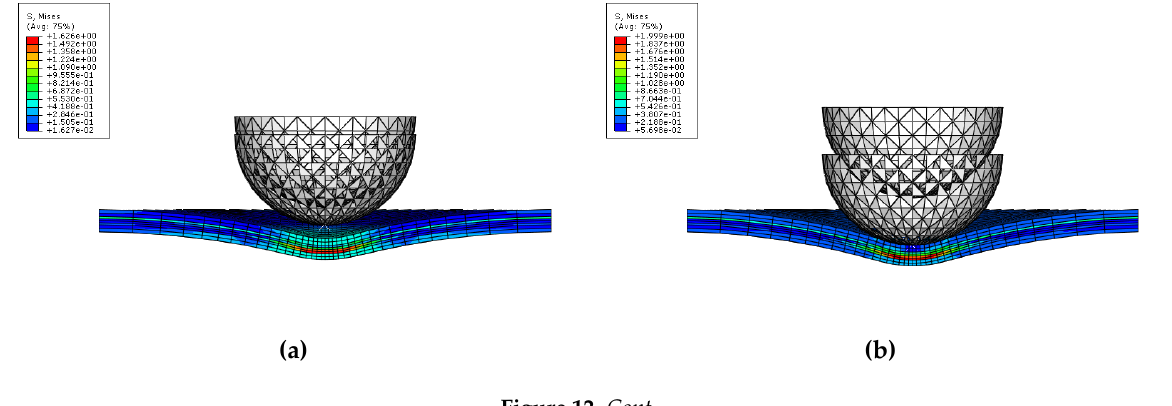
(d) Figure 12. Second impact applied on GLARE 5-2/1: ( a ) Time = 0 ms, ( b ) Time = 0.26 ms, ( c ) Time = 2.22 ms, ( d ) Time = 5.35 ms. Figure 13. Detection of stress at different locations. ( a )